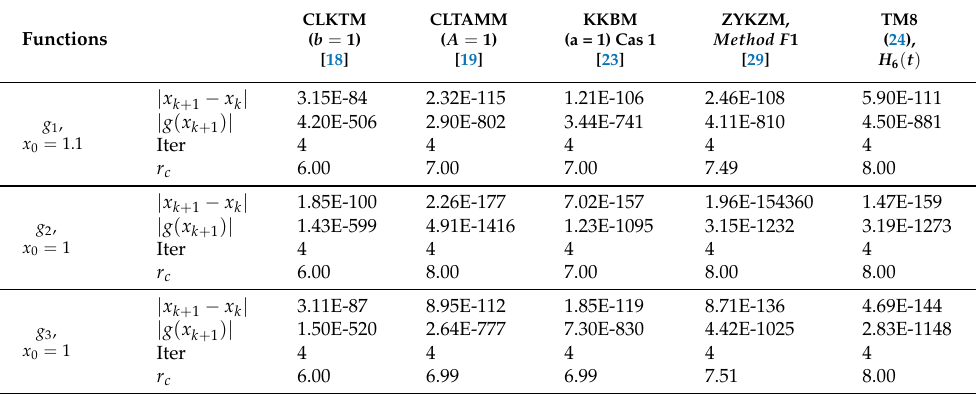
Table 7. Comparison of various iterative schemes (seventh